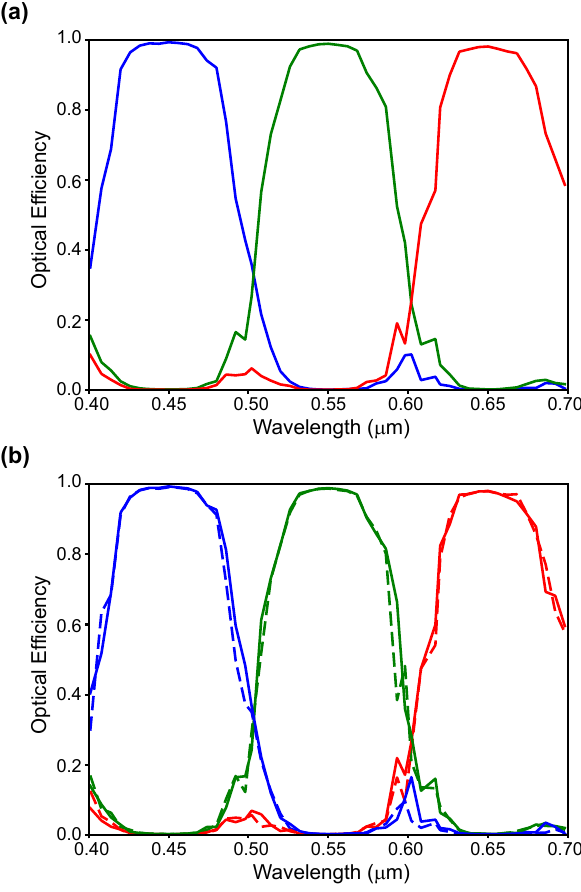
Figure 3: Broadband and polarization independent response of a subwavelength Bayer RGB color router.